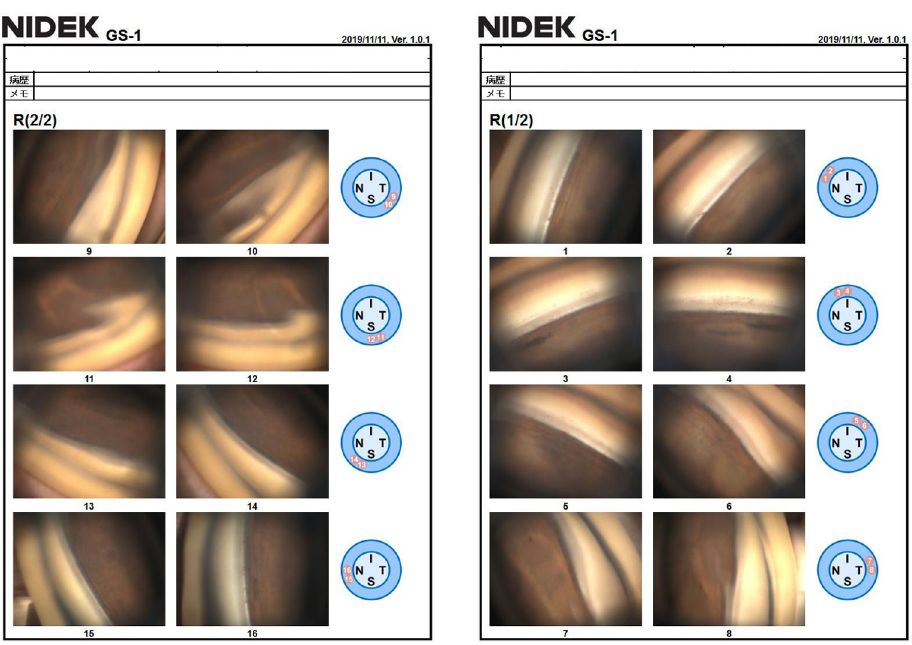
Fig 2. Representative GS-1 gonioscopic images in normal eyes. High-quality gonioscopic images in 16 directions are shown.